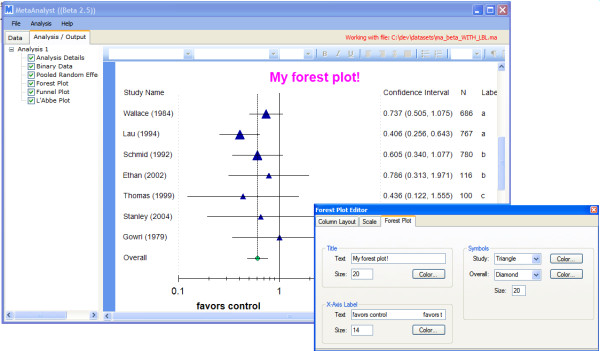
Forest Plot Editing.